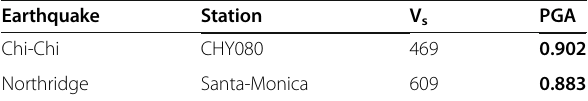
Table 3 Characteristics of ground motions used Earthquake